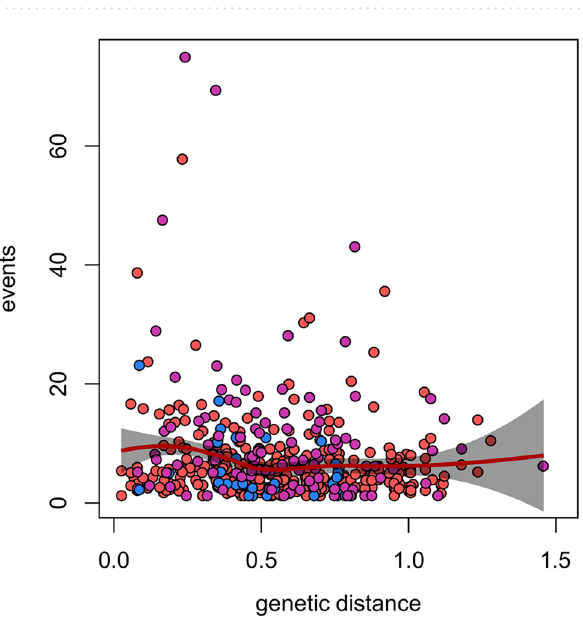
Figure 3. Relative swarming activity of individuals of different demographic categories of bats collected during three seasons calculated as ( a ) the mean number or ( b ) the maximum number of their events per night and roost (codes for sex and age categories: F = female, M = male, A = adult, O = old, Y = young, J = juvenile; categories are also colour coded). The distribution of individual observations in bean-plots (small horizontal lines) is shown by a kernel density shape and an median value (bold line). Different lower-case letters denote groups that significantly differ ( P < 0.05) from the others according to post-hoc Dunn tests with Bonferroni correction.